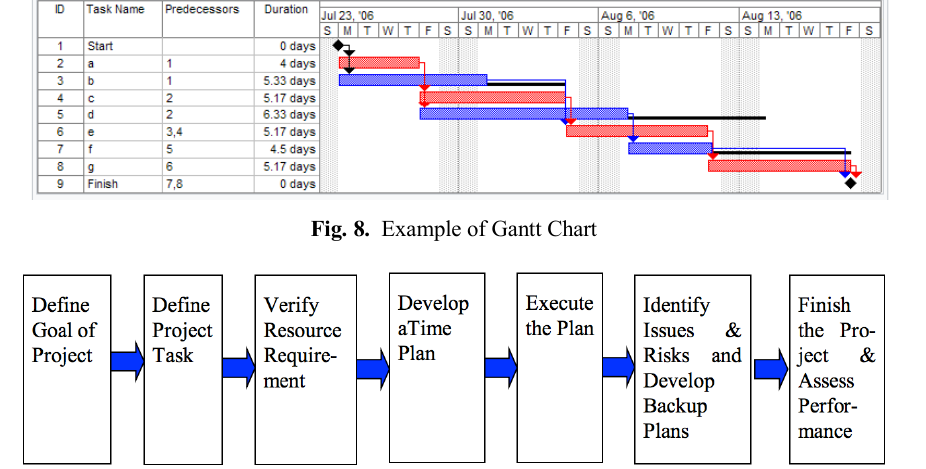
Fig. 9. Common Project Management Flow